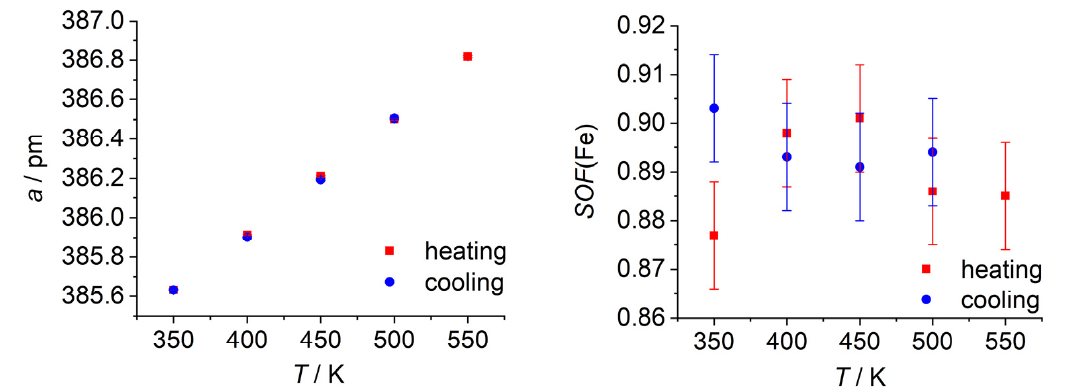
Figure A6. Refined structural parameters of ordered FePd 3 (long-time annealed sample, see Figure A5 and Tables A3 and A4) during isobaric variation of the temperature ( p (H 2 ) = 0.50(5) MPa) based on in situ XRPD data: lattice parameter (left) and SOF of iron at Wyckoff position 1 a (right). Error bars represent ± σ . Table A3. Conditions and refined parameters of the Rietveld refinement of FePd 3 (long-time annealed sample, Pm 3 m ) based on in situ XRPD data (see Figures A5 and A6, and Table A4) using Topas; X-ray absorption modeled with an overall B value of − 4 × 10 − 4 pm 2